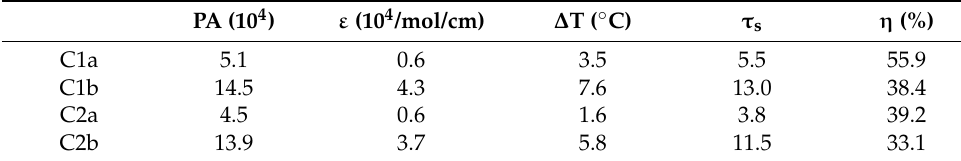
Table 1. Summary of PA intensity, ε , Δ T, τ s and η of the series of C-XY.